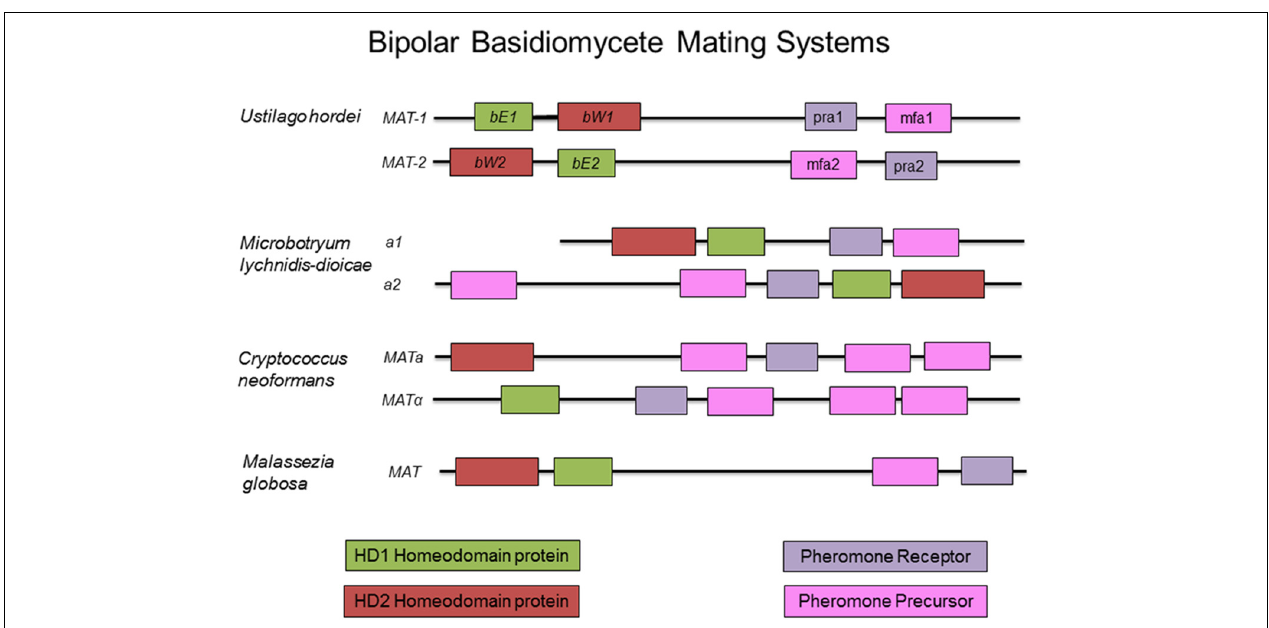
FIGURE 4 | Sample bipolar mating systems in basidiomycete fungi. While the two mating type loci of these organisms have become physically linked by chromosomal arrangement, the composition of the mating type loci remains similar to that found in tetrapolar systems. Boxes of the same color represent orthologous components in the different mating types and across